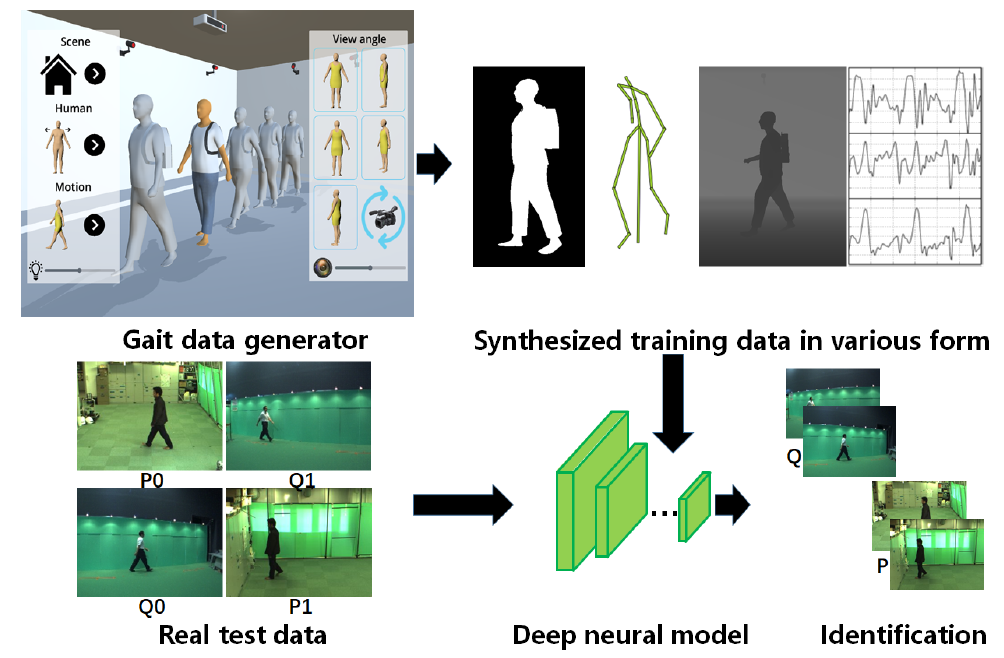
Figure 1. Synthesizing gait data for learning-based gait